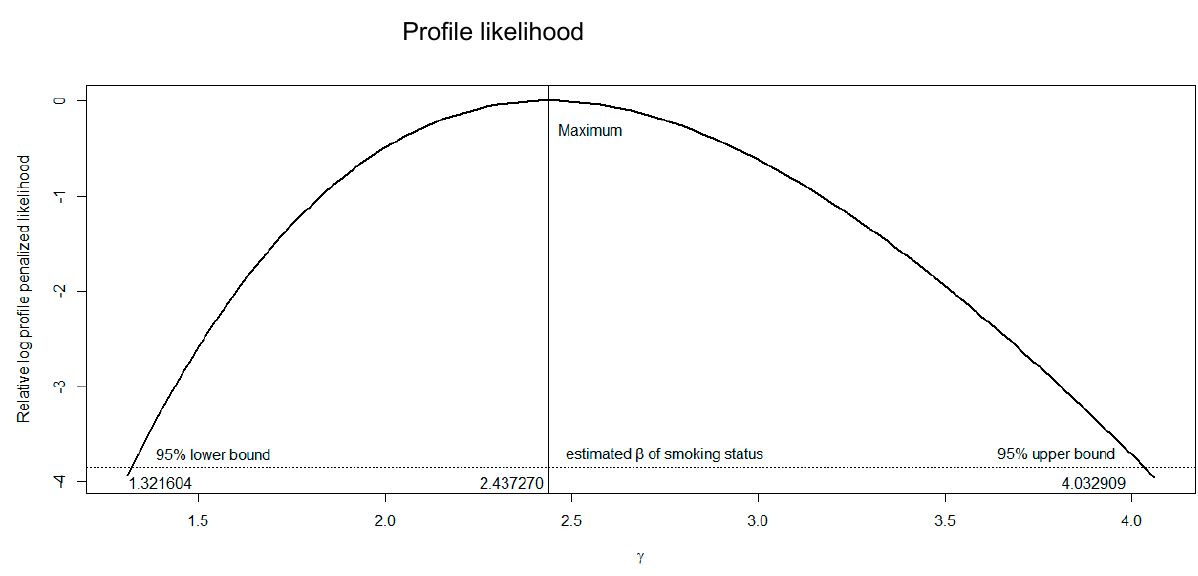
Figure 1. Plot of the profile penalized log-likelihood function for variable smoking status.